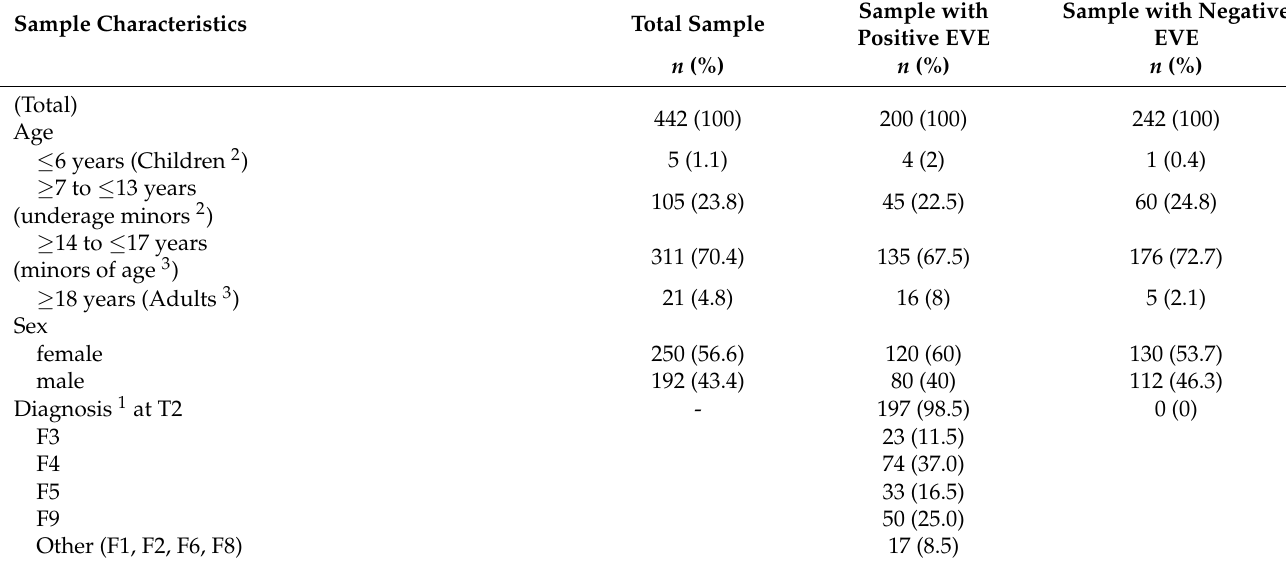
Table A1. Sample characteristics and comparison of participants and